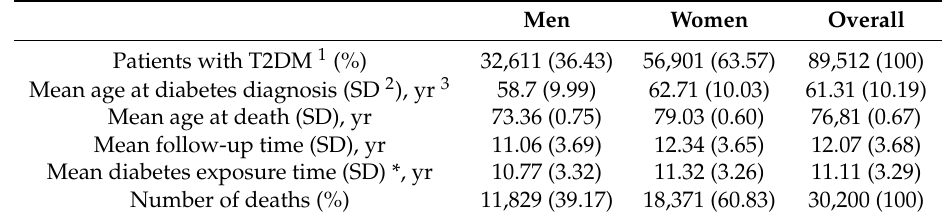
Table 1. Characteristics of the study